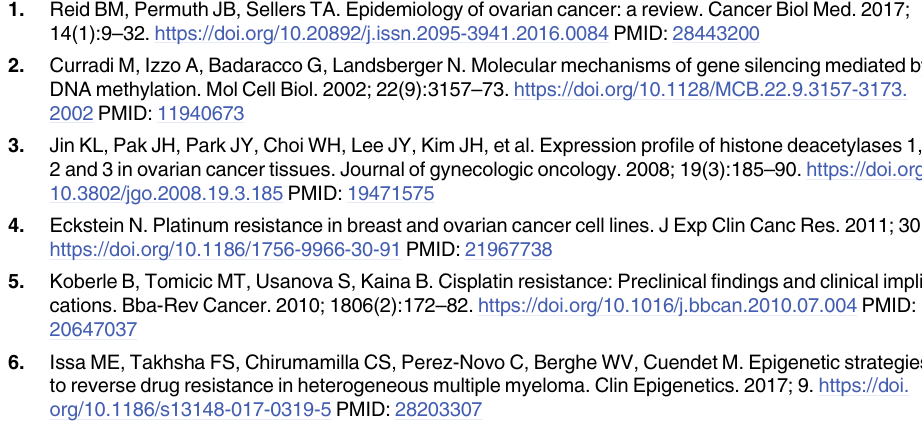
S1 Table. Primer sequences for the Bisulfite Next Generation Sequencing of CDH1. S1 Fig. Mapping of the CDH1 gene position relative to the chromosome. Schematic repre- sentation of analyzed E-cadherin promoter/exon1 regions. Individual CpG sites are highlighted.